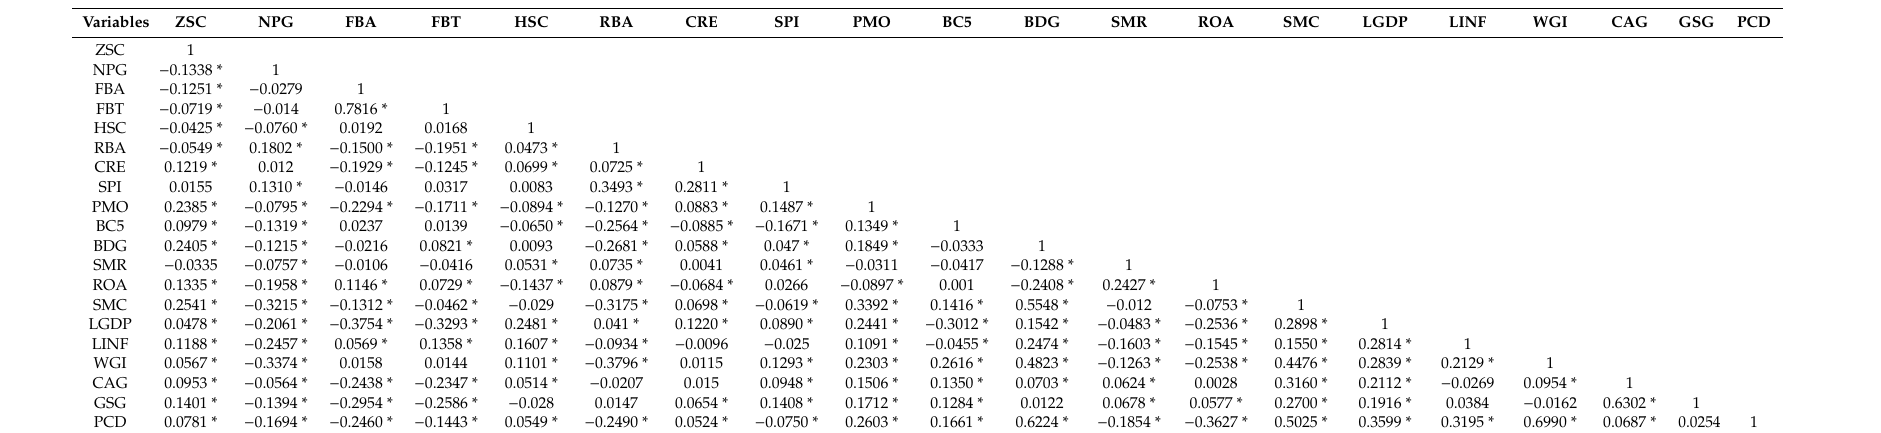
Table 2. Correlation